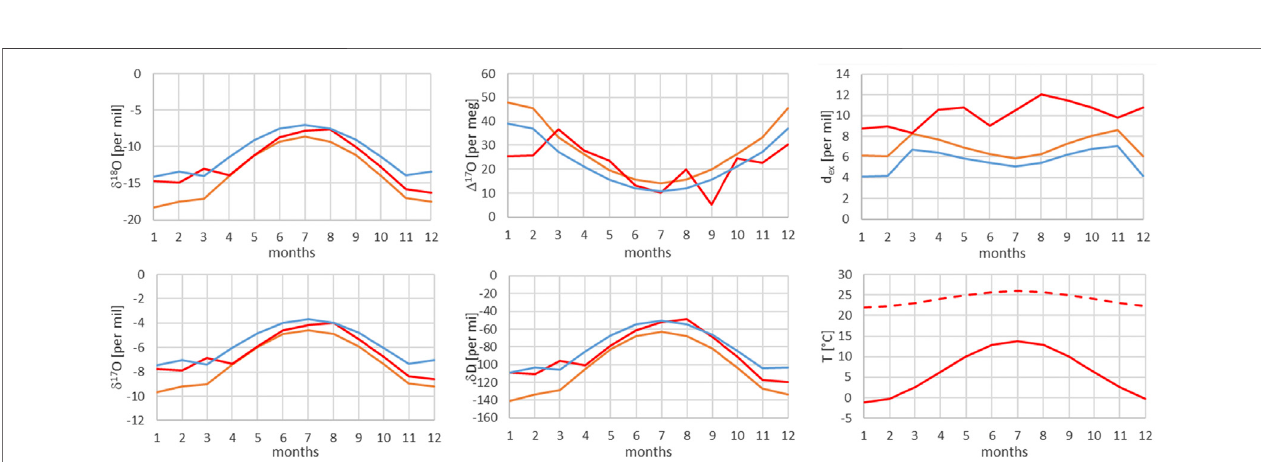
FIGURE 11 | Comparison of measured (red) and modeled (for the isobaric case (orange) and for the dry adiabatic case (blue)) isotope ratios for Guttannen. The dashed red line corresponds to the assumed source temperature.